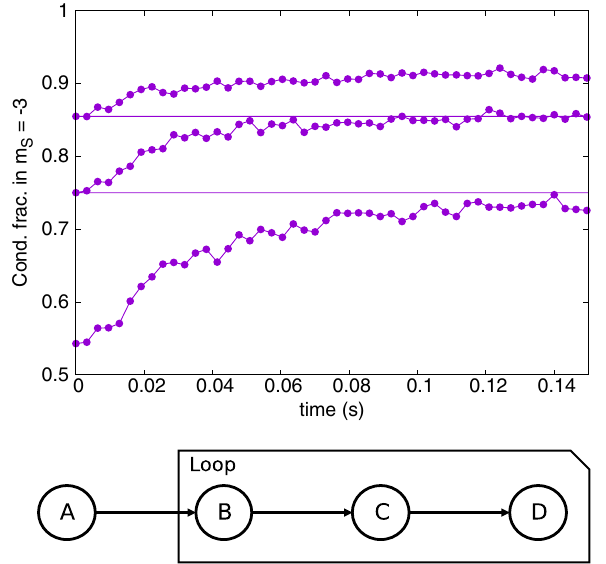
3 Zeeman component as a function of = − 235 nK at the k B T 0 using the initial temperature T 0 = =